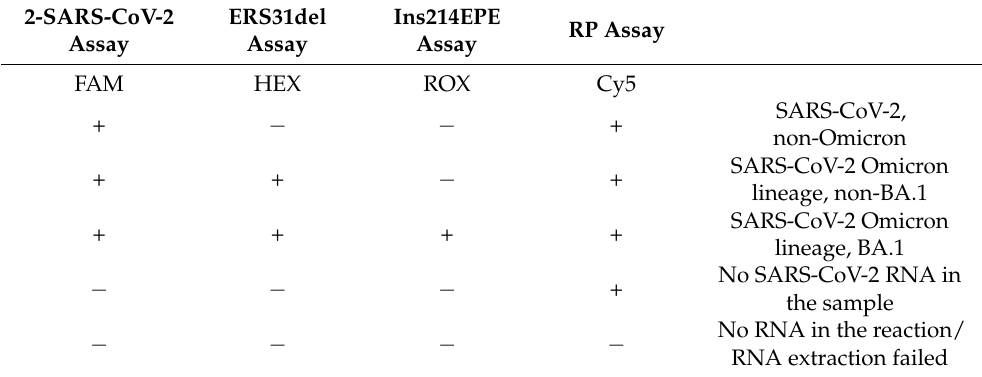
Table 4. Interpretation of the multiplex RT-qPCR assay results.